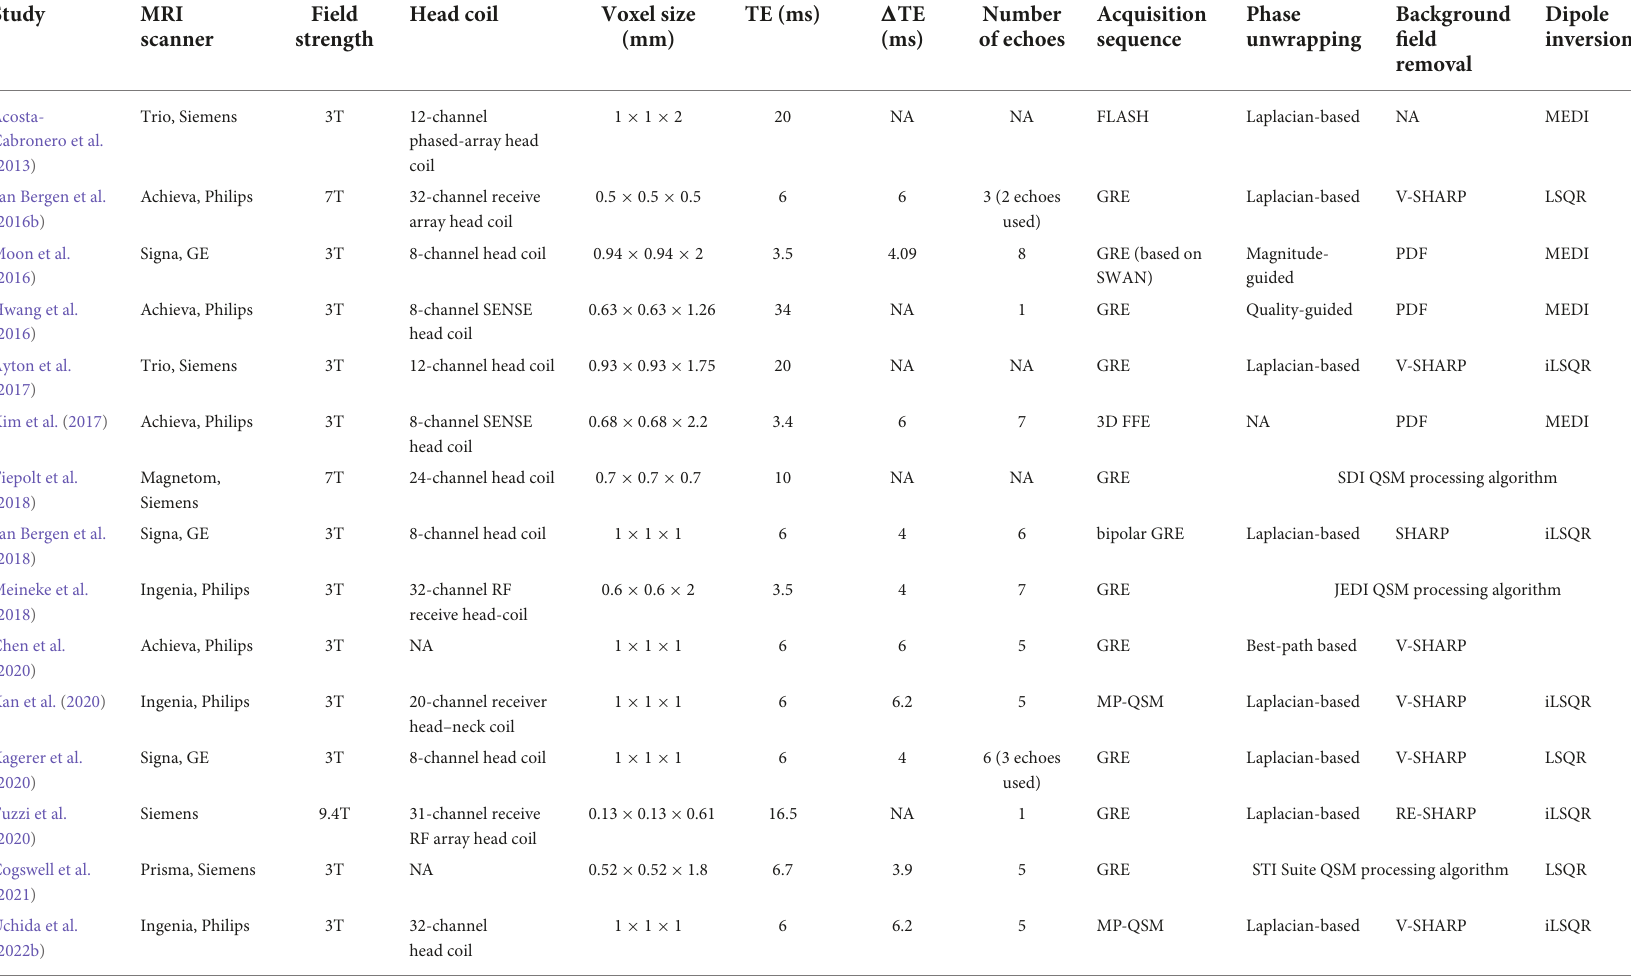
TABLE 1 Overview of MRI acquisition parameters and postprocessing techniques in QSM studies for AD continuum